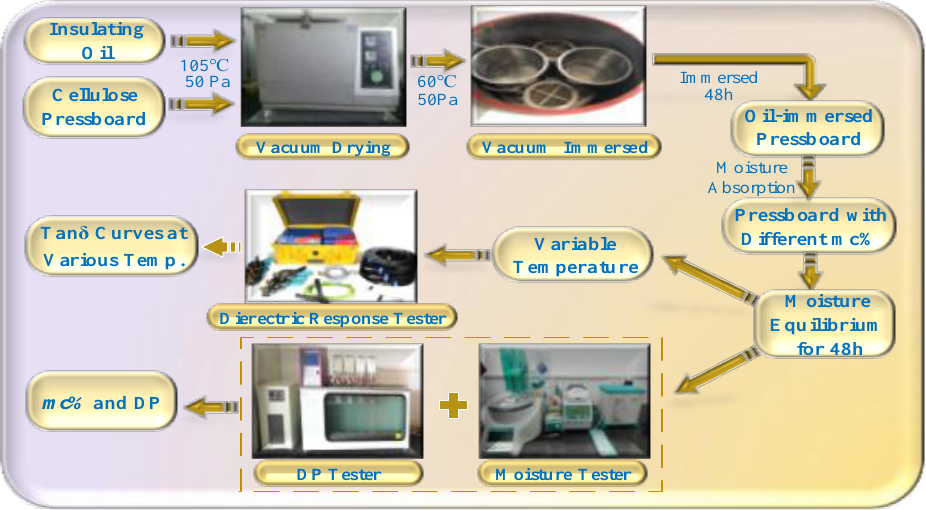
Figure 1. The experimental schedule of unaged pressboard with type I.